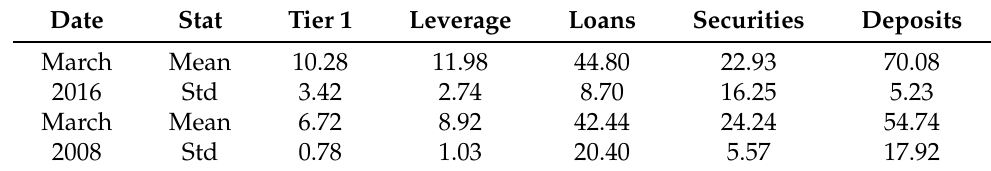
Table 1. Financial Ratios for the Top 5